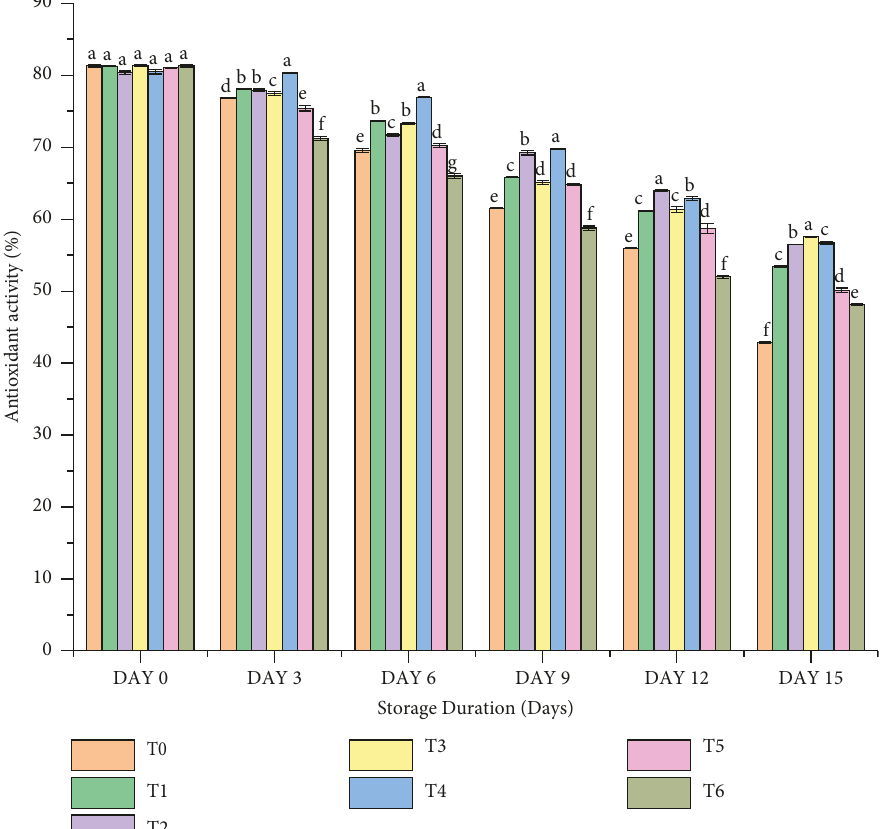
Figure 11: Effect of chitosan coating and cinnamon essential oil on the antioxidant content of pomegranate arils during storage at 4 ± 1 ° C. Vertical bars represent the mean ± SD of 3 replicates. Error bars with different letters on the same storage period show a significant difference ( P ≤ 0 . 05). T0 � control; T1 � 1% chitosan+0.25% oil; T2 � 1% chitosan+0.5% oil; T3 � 2% chitosan+0.25% oil; T4 � 2% chitosan+0.5% oil; T5 � 3% chitosan+ 0.25% oil; T6 � 3% chitosan+0.5%